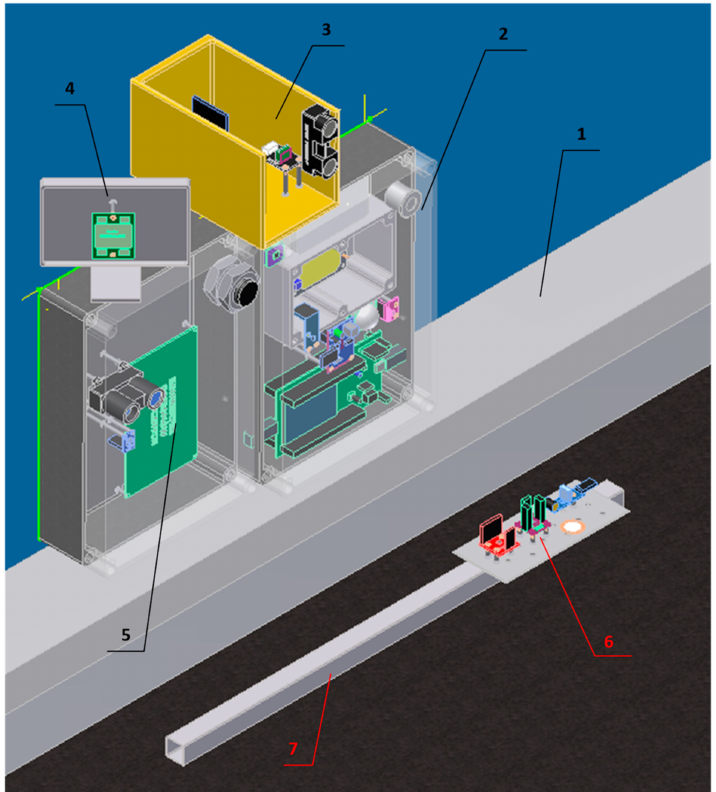
Figure 2. Second model of sensor node (SN2): (1) curb, (2) main box with microcontroller and sensors, (3) ultrasonic sensor, (4) Doppler radar, (5) LIDAR, infrared sensor, and infrared camera, (6) accelerometers, (7) aluminum profile glued to the road surface.